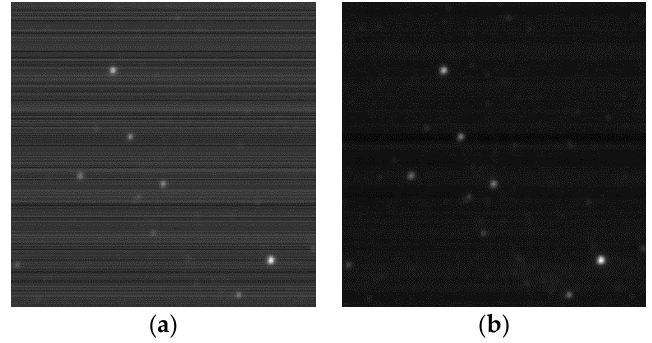
Figure 16. Implementing the proposed MICS-NUC algorithm to actual space scene. ( a ) Before NUC; ( b ) After NUC.